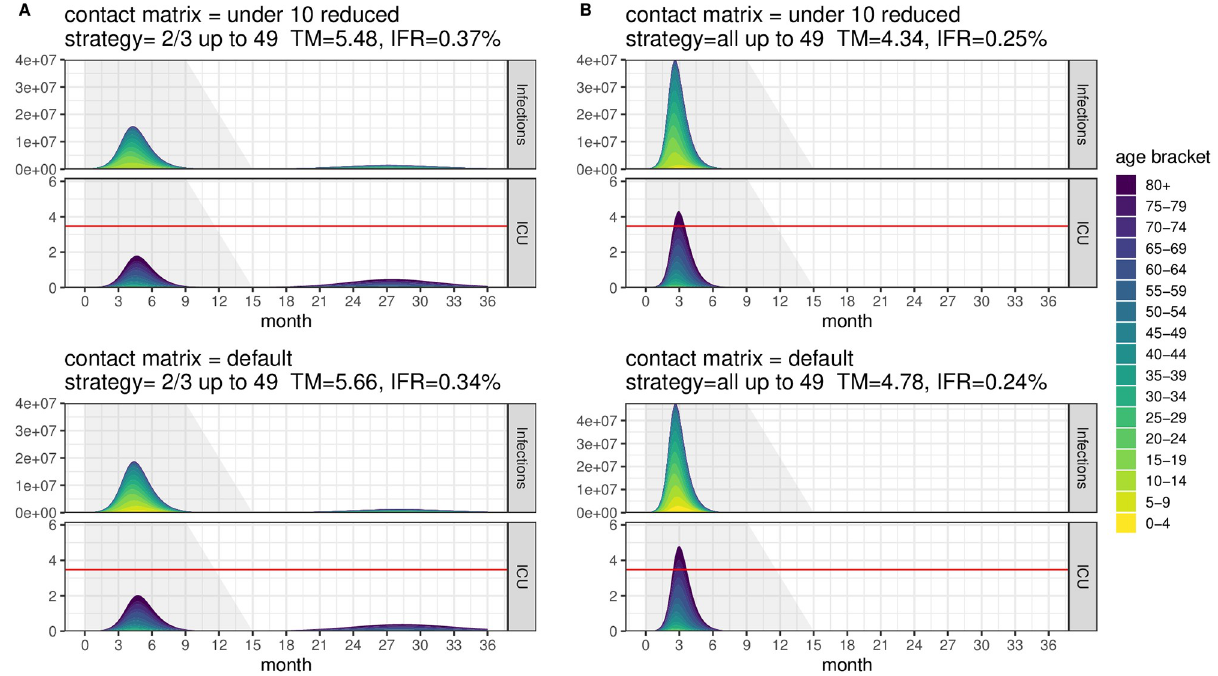
Fig 9. Comparison of the effect of reduced susceptibility and infectiousness of children under 10. The top two panels are generated using the modified contact matrix described in Fig 8 as a starting point. The bottom two panels are those generated using the contact matrix from Fig 1 as a starting point; note that these bottom panels are identical to the panels shown in Fig 6. We see only small quantitative differences between the top and bottom panels for each of the two strategies shown on the left and right here (releasing 2/3 or all of the under 60 population, respectively).